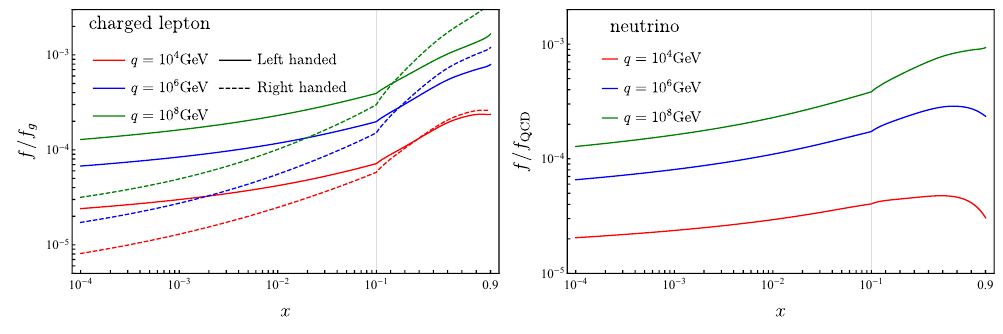
Figure 5 . First generation lepton PDFs normalized by the gluon PDF. Since we treat leptons as massless, and all leptons have the same initial condition, the results for the other 2 generations are identical. The thin gray line shows where the scales on the x- and/or y-axes switch between linear and